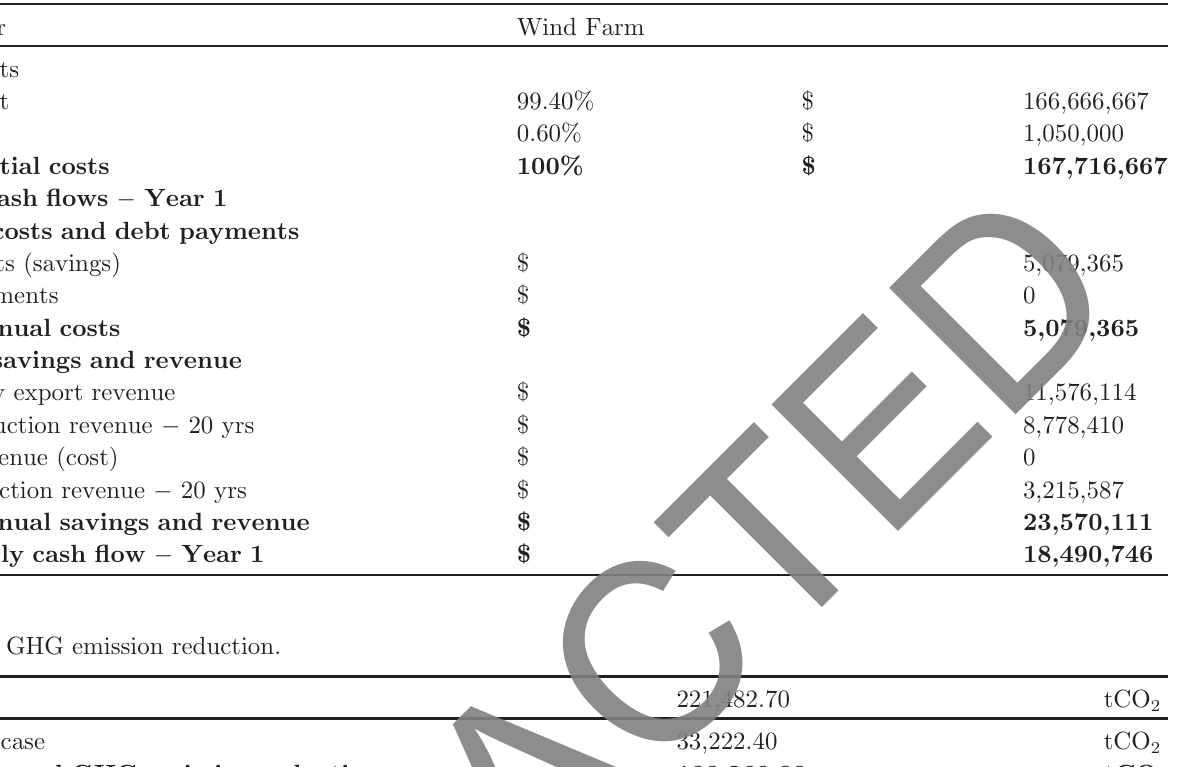
Table 5. Financial analysis results of the wind farm.